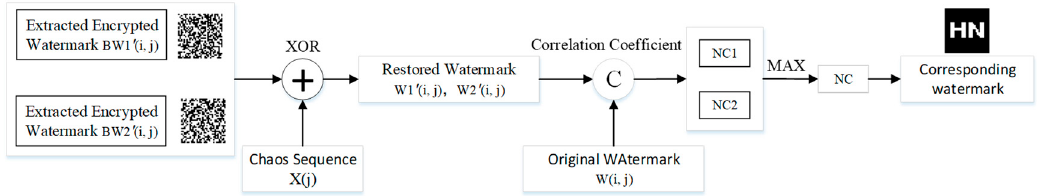
Figure 10. Decryption process of watermark .